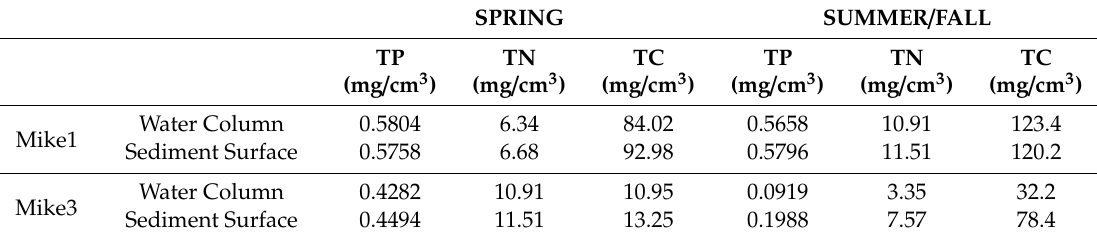
Table 3. Sediment total phosphorus (TP), total nitrogen (TN) and total carbon (TC) concentrations (mg / cm 3 ). Sediment was collected in sediment traps located at the sampling stations Mike1 and Mike 3 during the spring (n = 1) and summer / fall 2015 (n = 3) deployments. See Figure 2C and methods section for trap specifications and sampling